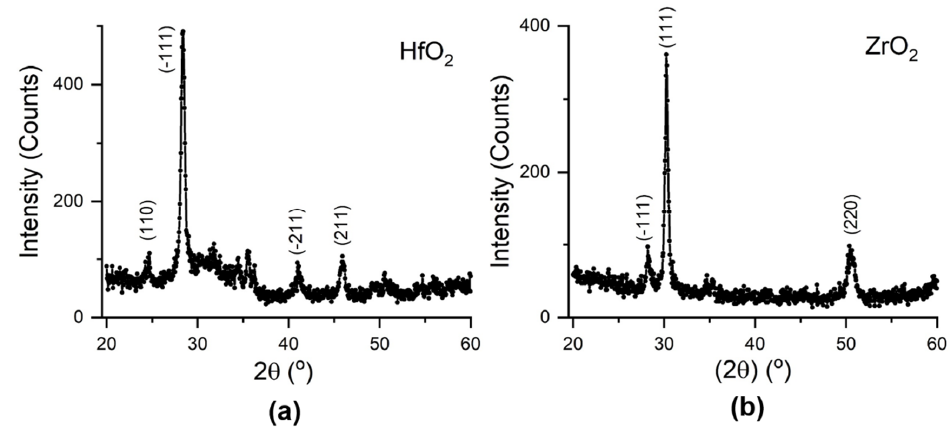
Figure 7. ( a ) X-ray di ff raction (XRD) spectroscopy of the HfO 2 thin film; ( b ) XRD spectroscopy of the Figure 7. ( a ) X-ray diffraction (XRD) spectroscopy of the HfO 2 thin film; ( b ) XRD spectroscopy of the ZrO 2 thin film. Crystals 2020 , 10 , x FOR PEER REVIEW ZrO 2 thin film. Figure 7. ( a ) X-ray diffraction (XRD) spectroscopy of the HfO 2 thin film; ( b ) XRD spectroscopy of the ZrO 2 thin film.